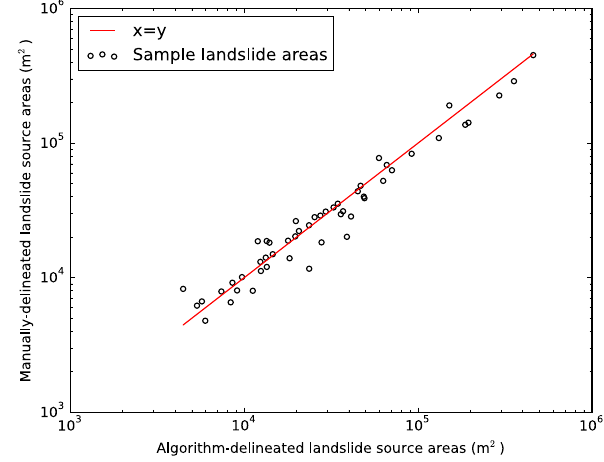
Figure B2. Comparison of manually and algorithm-delineated source areas, for a sample of 51 landslides. Manually and automati- cally delineated areas fall near the 1:1 line, showing that this tech- nique can provide an accurate approximation of the landslide source